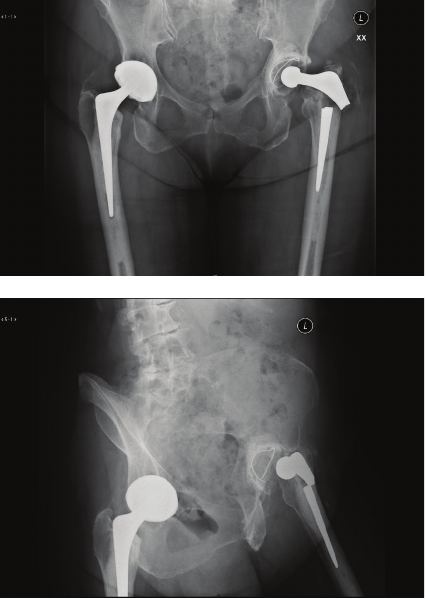
Figure 2: AP and Judet radiograph of the pelvis showing fracture through the left femoral stem prior to